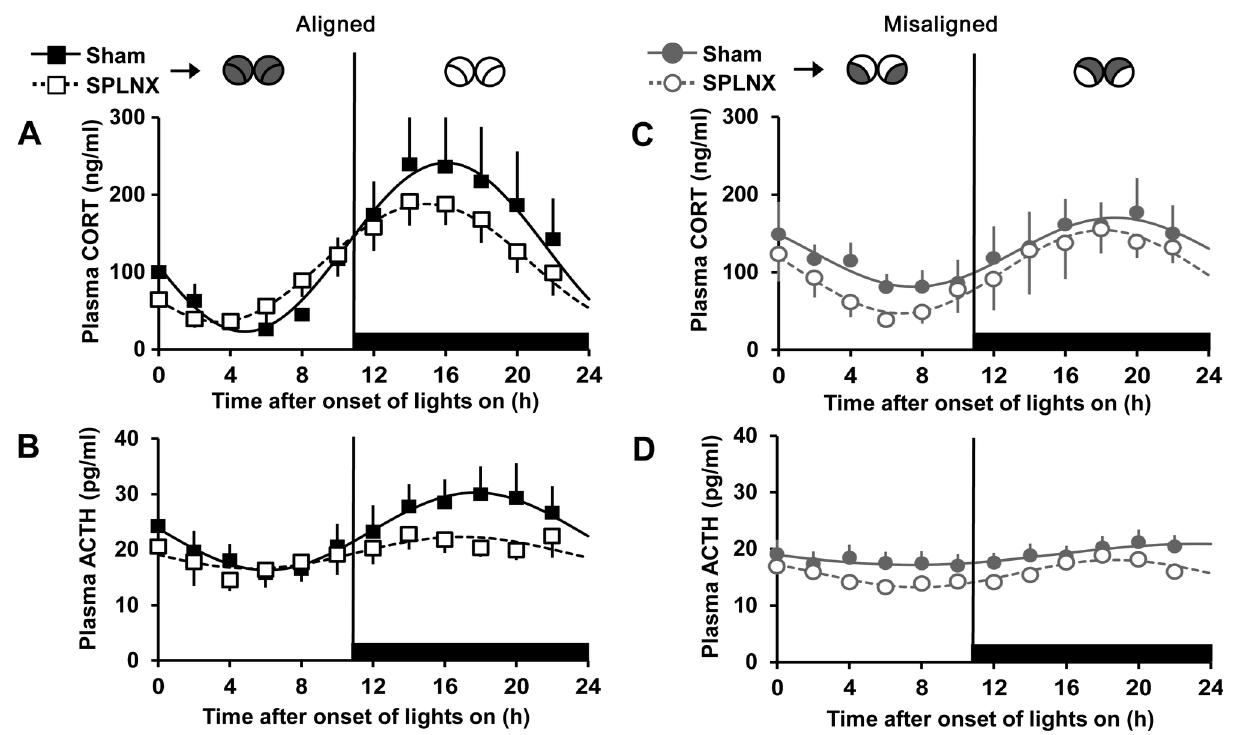
Figure 4. Splanchnicectomy reduces and phase advances the peak of the plasma corticosterone and ACTH rhythms. Plasma corticosterone (A and C) and ACTH (B and D) in Sham ( solid lines ) and SPLNX ( dotted line ) rats on aligned ( black ) and misaligned ( grey ) days. Black horizontal bars denote times when lights are off. Illustrations ( top ) show predicted Per1 expression patterns, as in Figure 2. Data from Sham animals are the same as those presented in Figure 3. Data are means ± SEM and fitted with a sine wave function (see materials and methods). n= 6-7